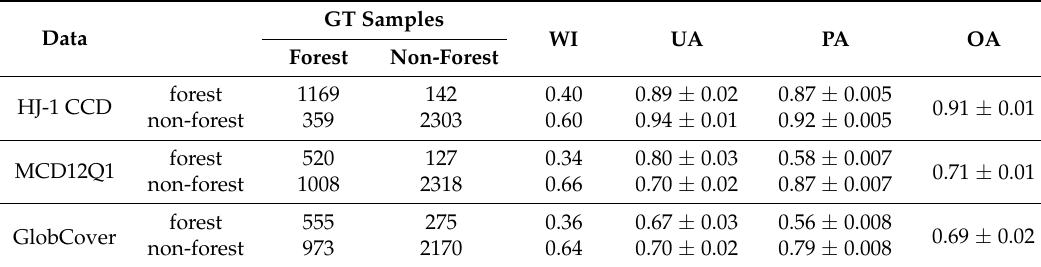
Table 4. Confusion matrix of accuracy assessments of the three forest maps with a 95% confidence interval.